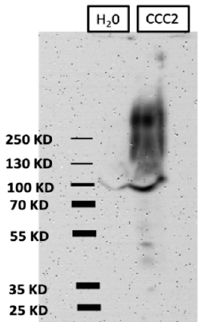
Figure 1. Heterologous expression of aeCCC2 in Xenopus oocytes. Western blot of total membrane fractions prepared from oocytes 3 days after injection with aeCCC2 cRNA (80 ng) or nuclease ‐ free H 2 O (80 nL). Molecular mass markers (kDa) are on the left. Note that an immunoreactive band of ~100 kDa appeared in membrane fractions of both H 2 O ‐ injected and aeCCC2 oocytes, which presumably indicates reaction of the aeCCC2 antibody with an endogenous protein in Xenopus oocytes.